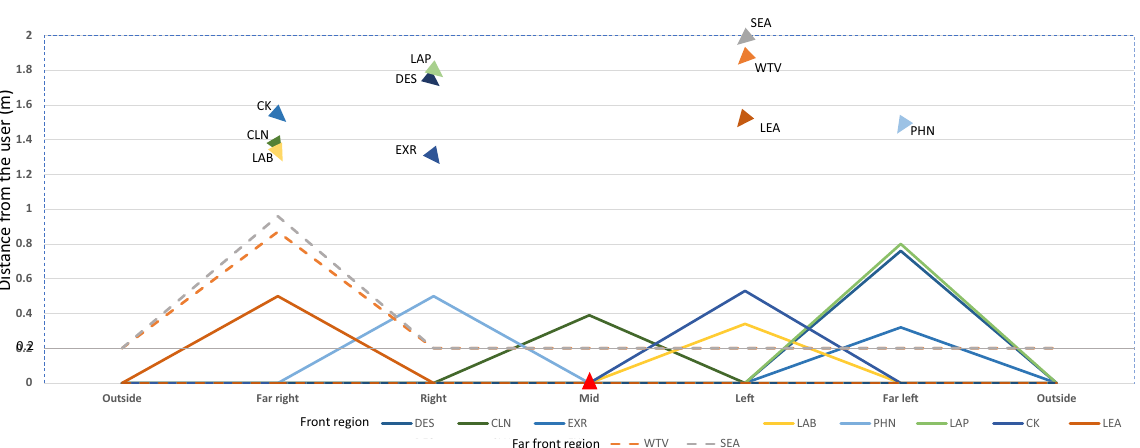
Figure 7: Distances considered maximum occupancy regions of the selected set of tasks are marked here. The red triangle denotes the position of the user and the other colored triangles denote the position and orientation of the robot during each task. The size of the triangle is not scaled with the size of the user or robot but the orientation is marked by measuring θ . Colored contours represent the restricted area for the robot to invade while approaching its user.